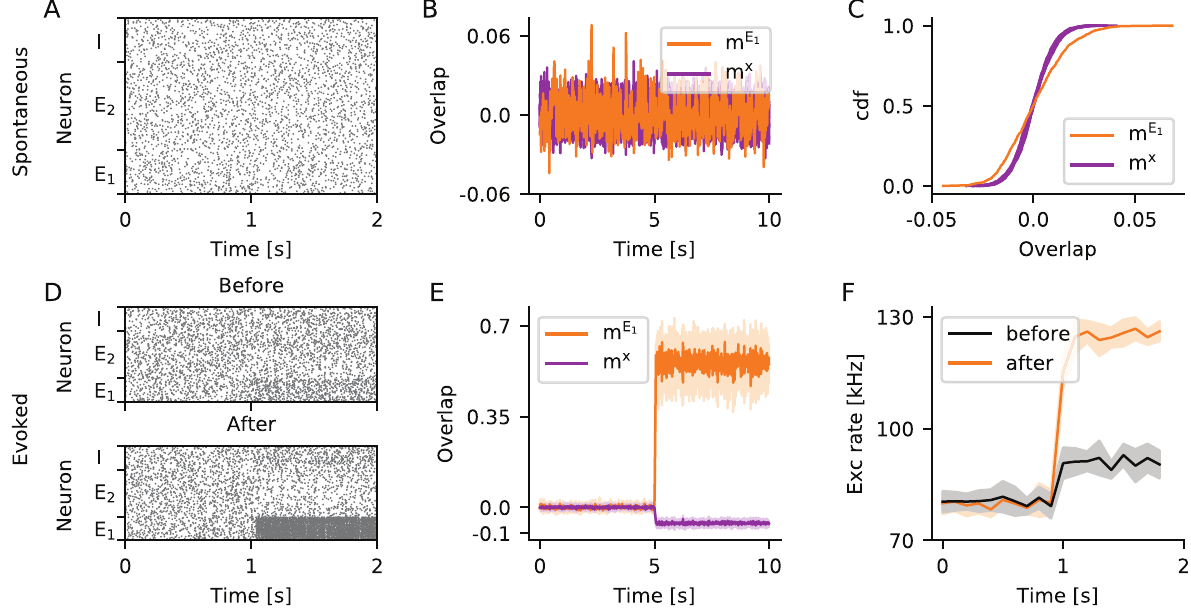
Fig 2. Silent memory based on structural engrams. (A–C) The ongoing activity of neurons belonging to the engram E 1 can hardly be distinguished from the activity of the rest of the network. (A) Raster plot showing the spontaneous activity of 50 neurons randomly selected from E 1 , 100 neurons randomly selected from E 2 but not belonging to E 1 , and 50 neurons randomly selected from the pool I of inhibitory neurons. (B) Overlap of ongoing network activity with the learned engram E 1 ( m E 1 , orange), and separately for 10 different random ensembles x disjoint with E 1 ( m x , purple). (C) Cumulative distribution of m μ shown in (B). (D–F) The activity evoked upon stimulation of E 1 is higher, if the within-engram connectivity is large enough ( � C > 0 : 1 ) as a consequence of learning. (D) Same as A for evoked activity, the stimulation starts at t = 1 s. The neurons belonging to E 1 E 1 engram E 1 are stimulated before (top, � C � 0 : 1 ) and after (bottom, � C � 0 : 21 ) engram encoding. (E) Overlap with the learned engram ( m E 1 , E 1 E 1 E 1 E 1 orange) and with random ensembles ( m x , purple) during specific stimulation of engram E 1 . (F) Population rate of all excitatory neurons during stimulation of E 1 before (black) and after (orange) engram encoding. (E, F) Solid line and shading depict mean and standard deviation across 10 independent simulation runs, respectively. In all panels, the bin size for calculating overlaps is 10 ms, and the bin size for calculating population rates is 100